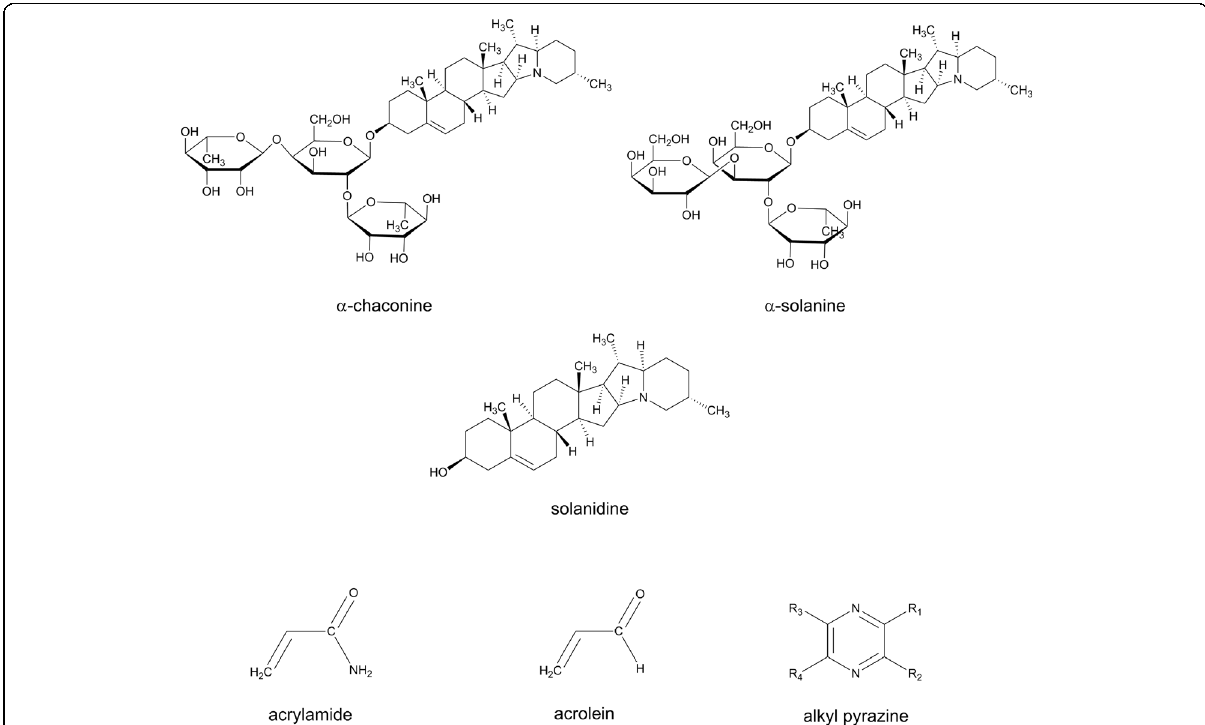
Fig. 2 Structures of candidate biomarkers and precursors for potatoes and potato